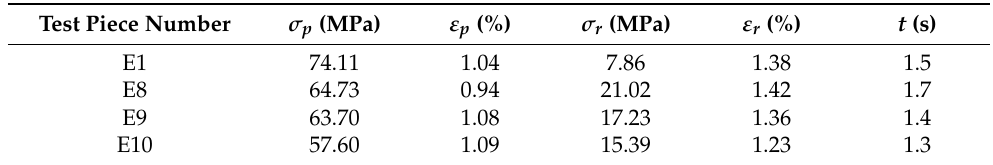
Table 5. Parameters required for calculating the brittleness index of limestone samples with different water content rates.